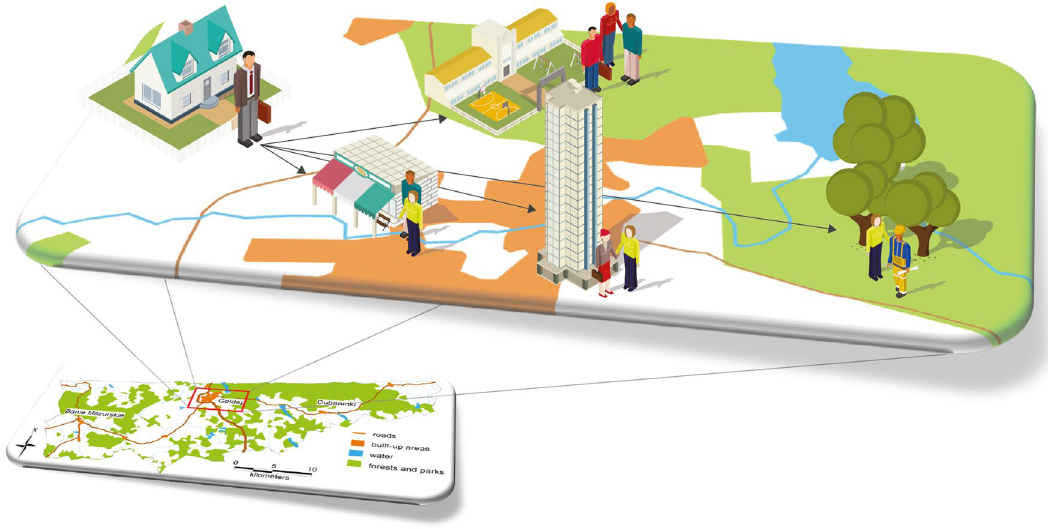
Figure 1. Model of an agent’s spatiotemporal interactions (developed by the authors).